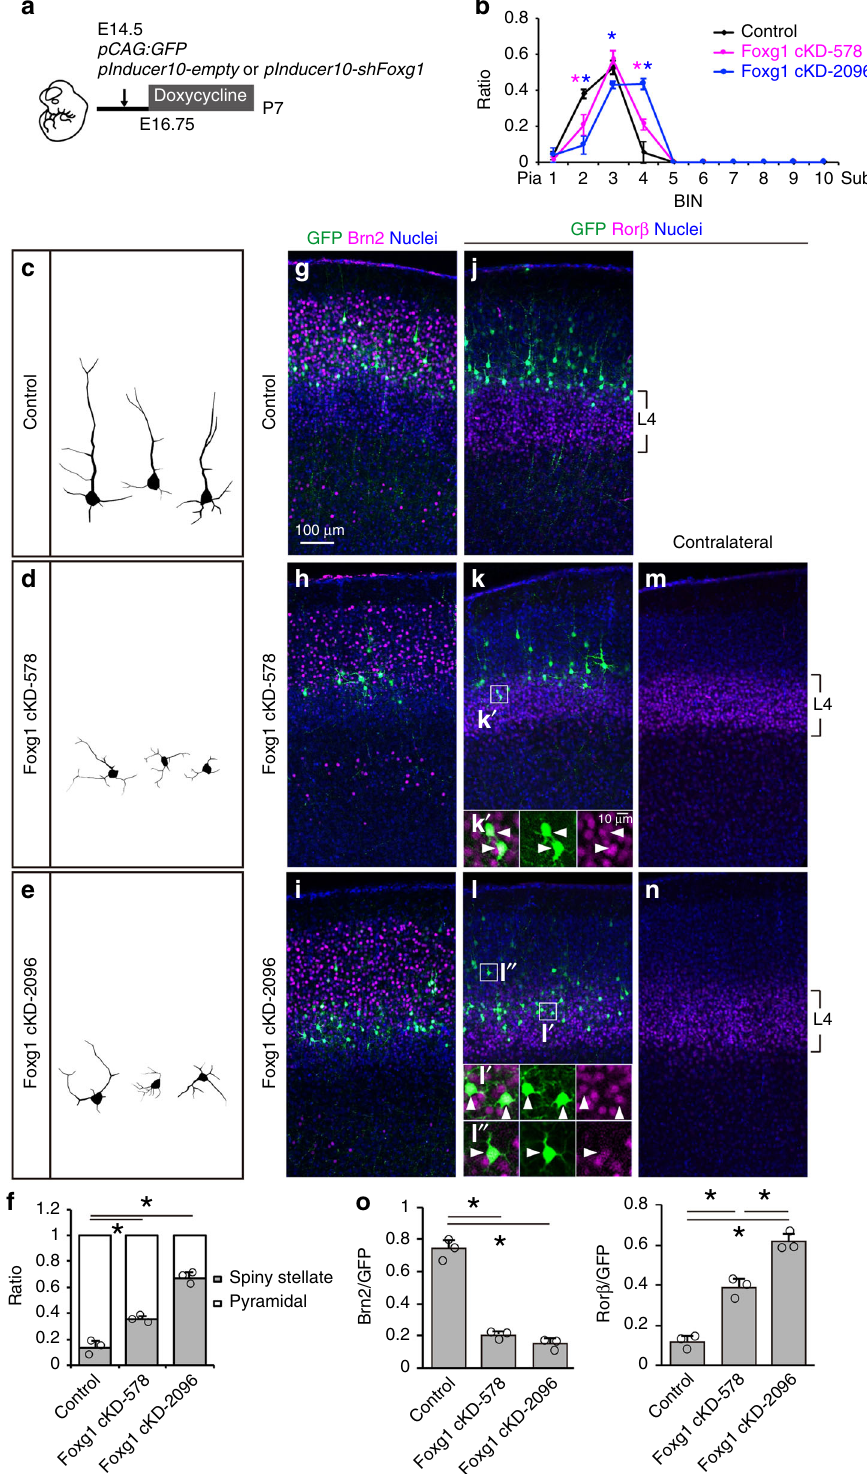
Fig. 7 Conditional suppression of Foxg1 converts layer 2/3 to layer 4 neuron identity. a Schematic diagram of inducible Foxg1 knockdown using the pInducer system. Doxycycline was administered from E16.75 to suppress Foxg1 expression. b Quantitative analysis of the distribution of GFP cells in P7 cortices. Cortical plate is divided into 10 BINs from the pia to the subplate. c – e Representative reconstruction of GFP cells from P7 cortices. f Quantitative analysis of the percentage (±SEM) of GFP cells with spiny stellate or pyramidal morphology. g – n Double immunohistochemistry for GFP (green) with Brn2 (red) ( g – i ) or Ror β (red) ( j – n ). o Quantitative analysis of the percentage (±SEM) of GFP cells that express Brn2 or Ror β . * indicates P value <0.05 by Student ’ s t -test. Source data are provided as a Source Data fi